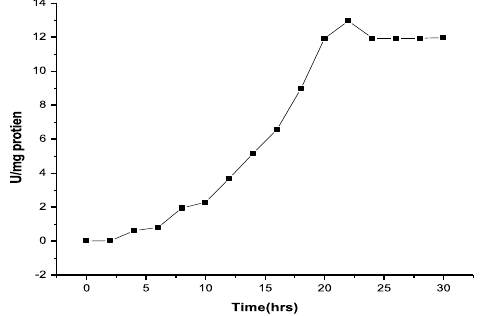
Fig. 4. Enzyme production of Rhodococcus sp . LKE-021